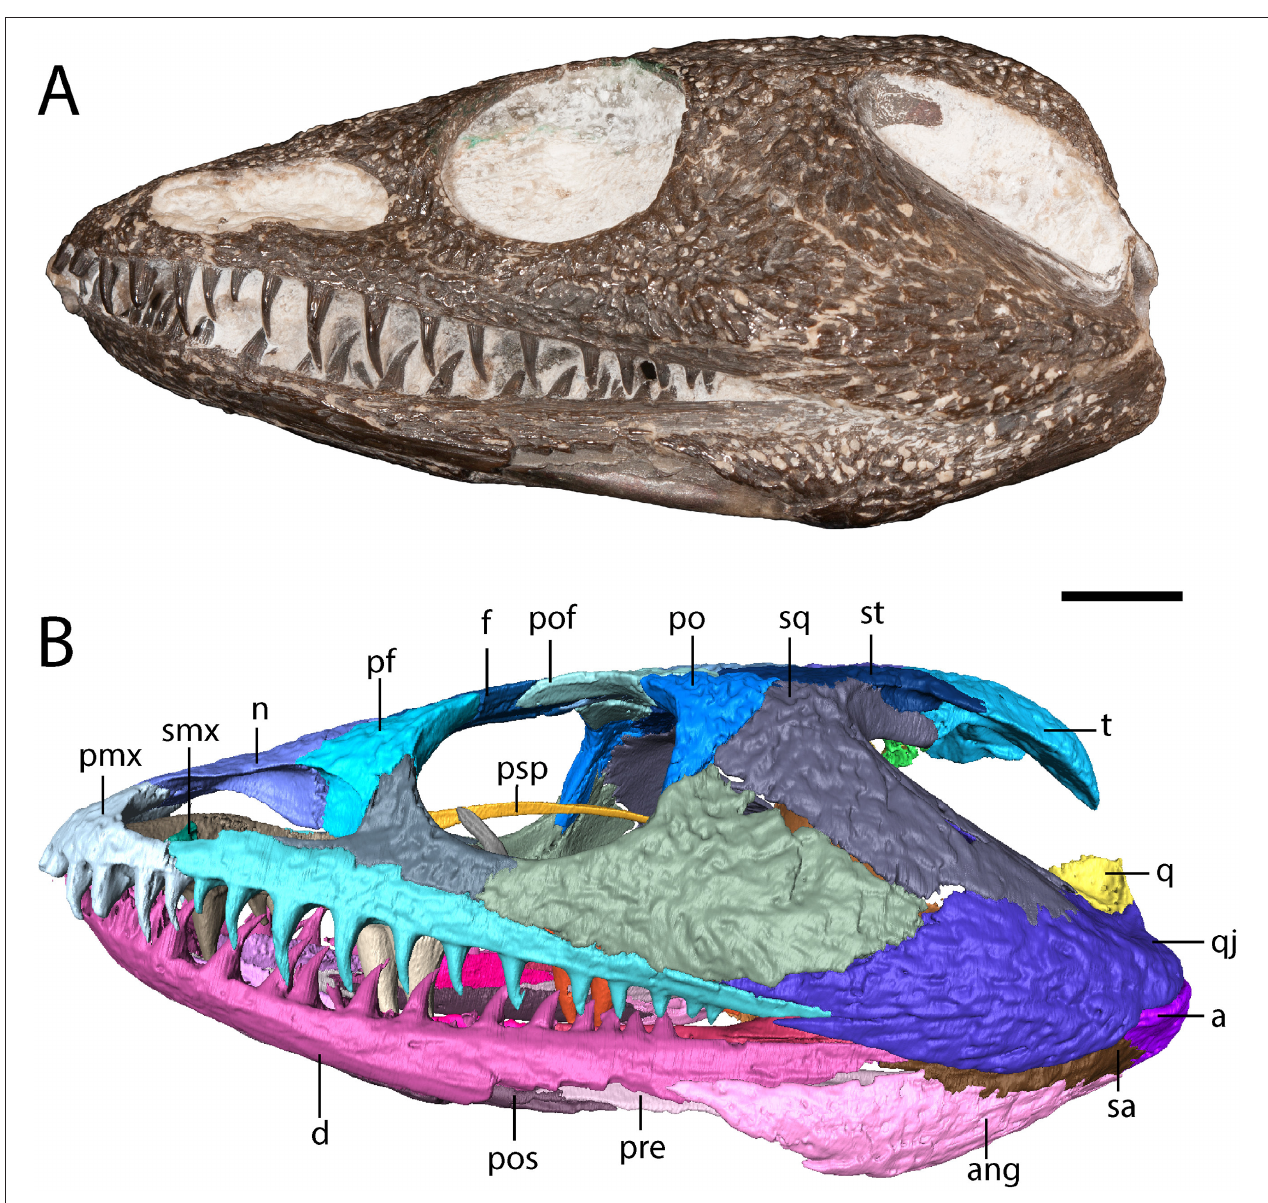
FIGURE 2 | OMNH 79318, cf. Acheloma , entire specimen in left lateral profile. (A) photograph; (B) digitally segmented rendering. Scale bar equal to